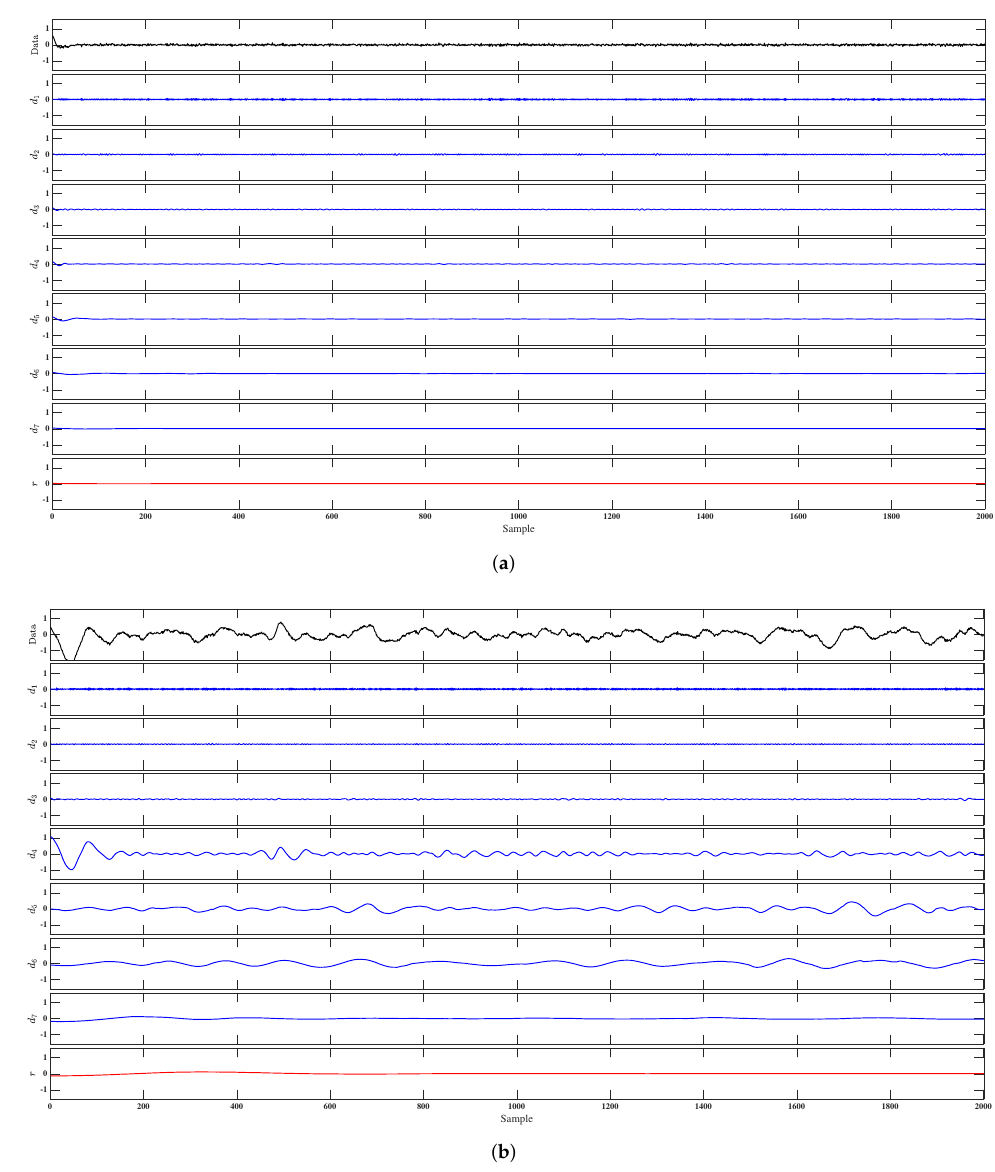
Figure 10. Oscillation decomposition sample using MEEMD algorithm for the variable (cid:101) 3 in simulated data. The first subplot shows original data (Data) and the consecutive plots show decomposed frequencies and the residuum in the last subplot. ( a ) Gaussian noise case, ( b ) Gaussian noise, and Cauchy disturbance